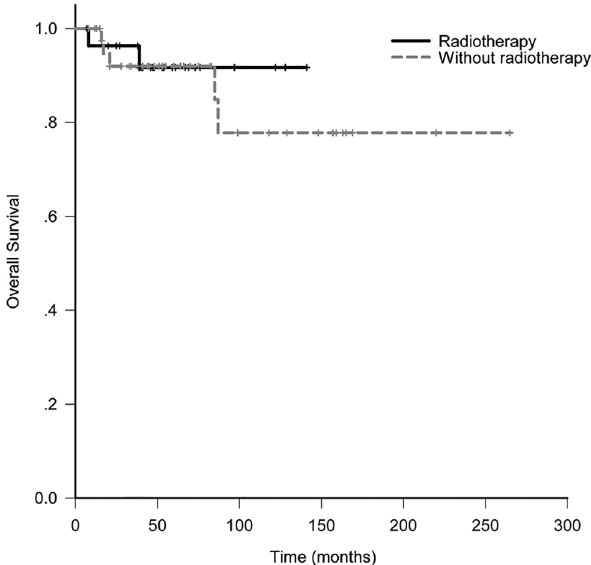
Fig 3. Overall survival of patients with or without